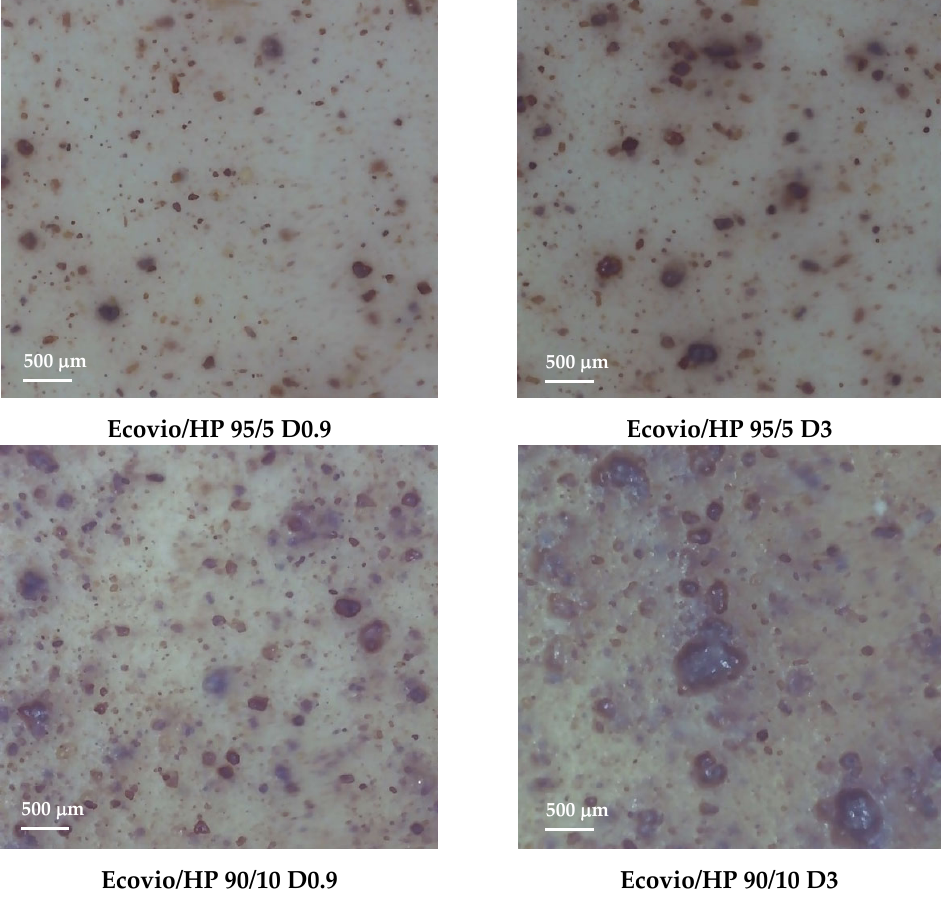
Figure 6. Optical microscopy images of Ecovio/HP 95/5 and Ecovio/HP 90/10 active films produced with different draw ‐ up rates.